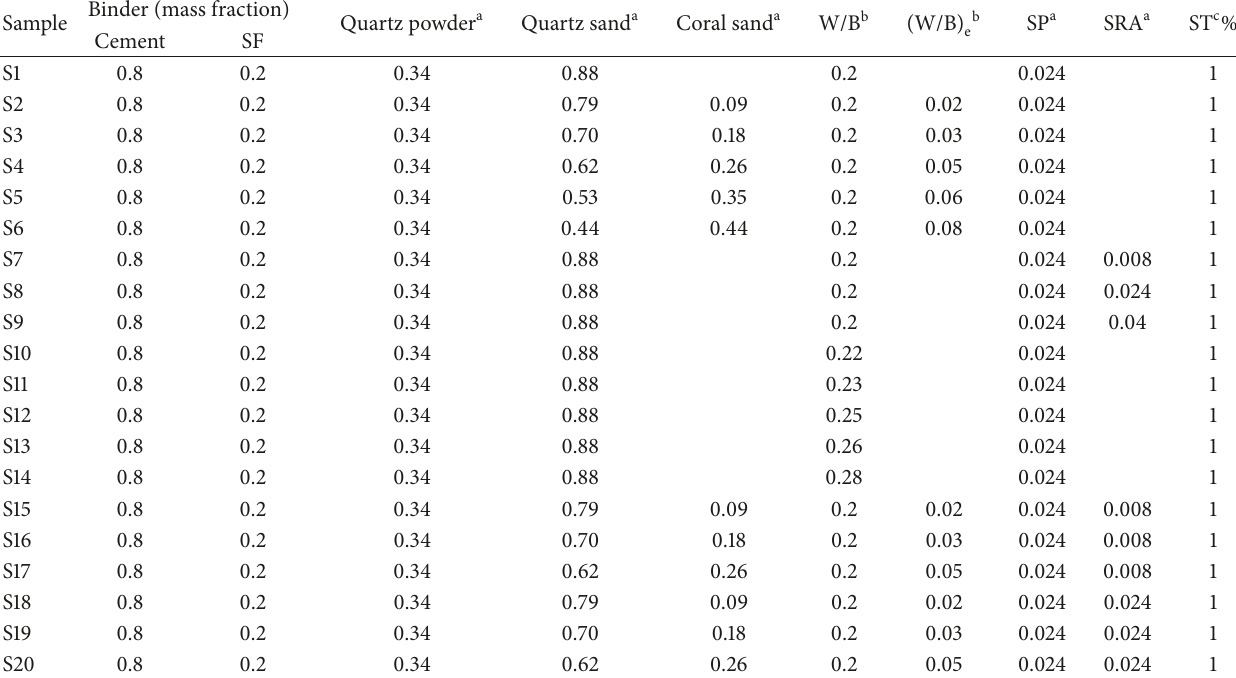
Table 3: The mix proportion of UHPC.